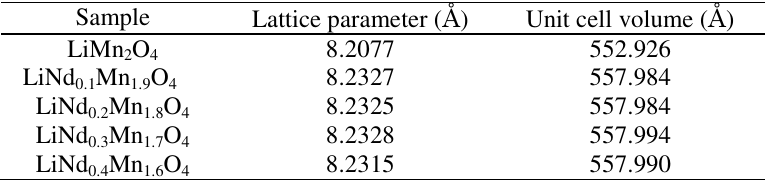
Table 1. Lattice parameter of